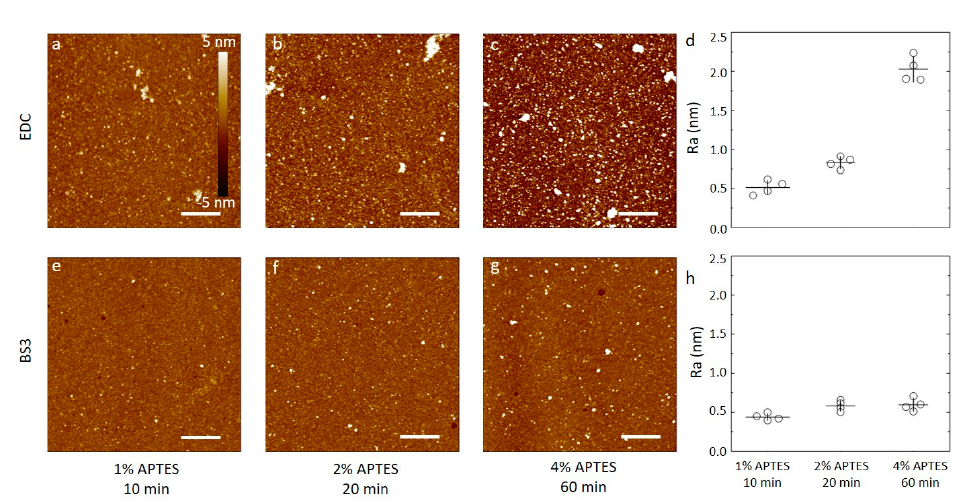
Figure 5. ( a – c , e – f ) AFM height topographs of anti-CRP antibodies immobilized on silicon substrates silanized using APTES dissolved in 96% ethanol. ( a – c ) Height topographs of anti-CRP immobilized by carbodiimide chemistry (EDC) to substrates silanized using APTES concentrations and durations of ( a ) 1% APTES, 10 min, ( b ) 2% APTES, 20 min, and ( c ) 4% APTES, 60 min. ( d ) The average surface roughness obtained from 5 µ m × 5 µ m AFM topographs (n = 4, for each condition) of anti-CRP immobilized on silanized silicon. ( e – f ) Selected AFM height topographs of anti-CRP immobilized using the BS3 linker to silicon substrates silanized using APTES concentrations and durations of ( e ) 1% APTES, 10 min, ( f ) 2% APTES, 20 min, and ( g ) 4% APTES, 60 min. ( h ) The average surface roughness obtained from 5 µ m × 5 µ m AFM topographs (n = 4, for each condition) of anti-CRP immobilized using BS3 on silanized silicon substrates. The height scalebar for all topographs are shown in Figure 4a. The lateral scalebars on the AFM topographs are 1 µ